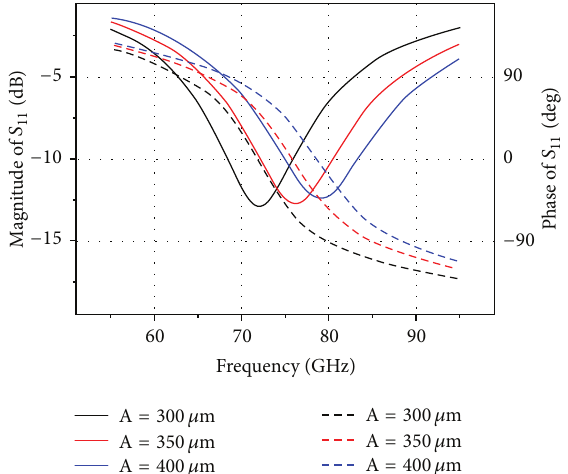
Figure 2: Magnitude and phase of reflection coefficient of the dogbone shape AMC.